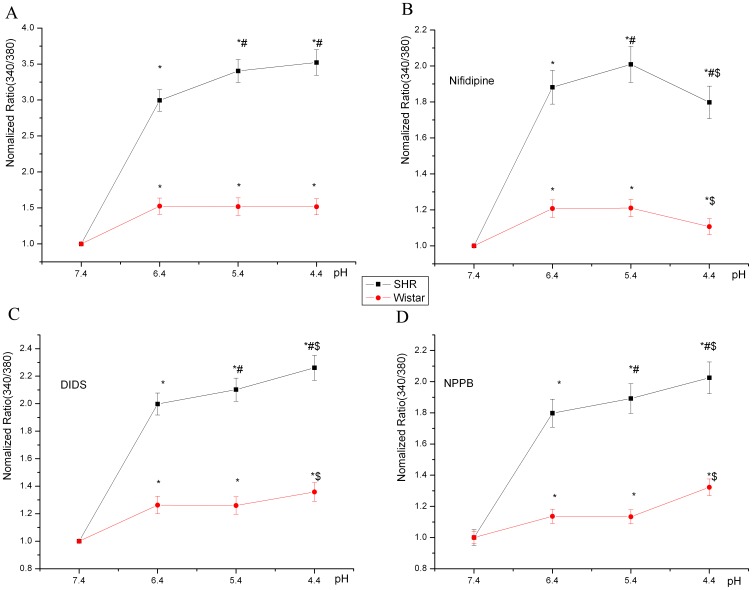
Effect of ICl,acid and VDCC blocker on severe acidosis-increased intracellular calcium concentration.A Without any treatment, [Ca2+]i at pH 6.4, 5.4 and 4.4 in SMCs from SHRs and Wistar rats. B, VDCC blocker nifedipine (10 µM) inhibited severe acidosis-increased [Ca2+]i for both SHRs and Wistar rats at different pHs. C, (DIDS, 100 µM), D, (NPPB, 100 µM), ICl,acid blockers inhibited severe acidosis-increased [Ca2+]i. *P<0.01, compared with [Ca2+]i at pH 7.4. #
P<0.05, compared with [Ca2+]i at pH 6.4. $
P<0.01, compared with [Ca2+]i at pH 5.4.